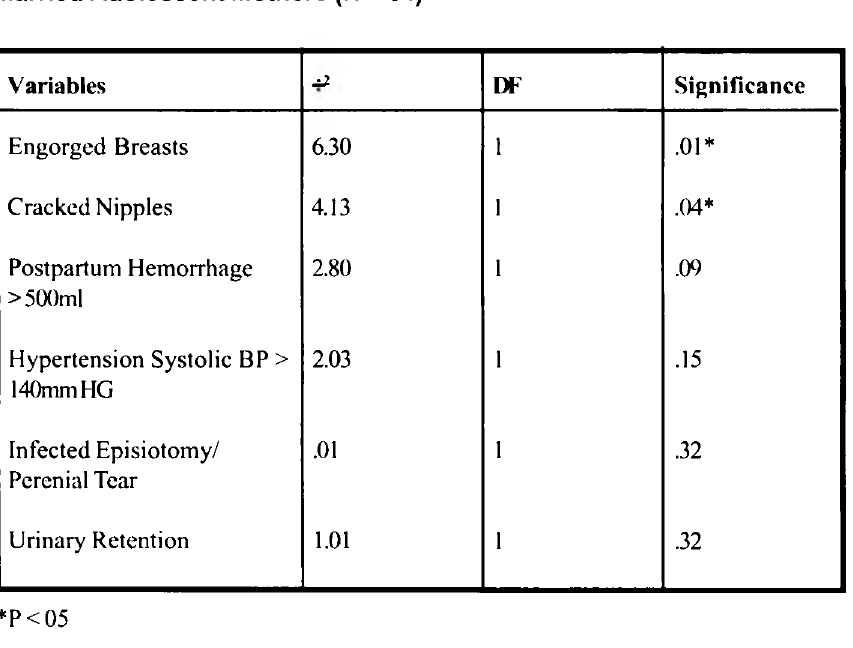
Table 7 A Summary of Chi-Square analysis on Postpartum Complication Checklist for Unmarried Adolescent Mothers (N = 64) and Married Adolescent Mothers (N =